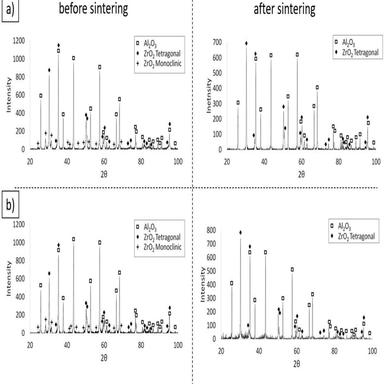
Diffractograms of composite samples before and after sintering: a) Series I - 40 vol.%of solid phase with 10% vol. of ZrO2, b) Series II - 45 vol.%of solid phase with 10% vol. of ZrO2.